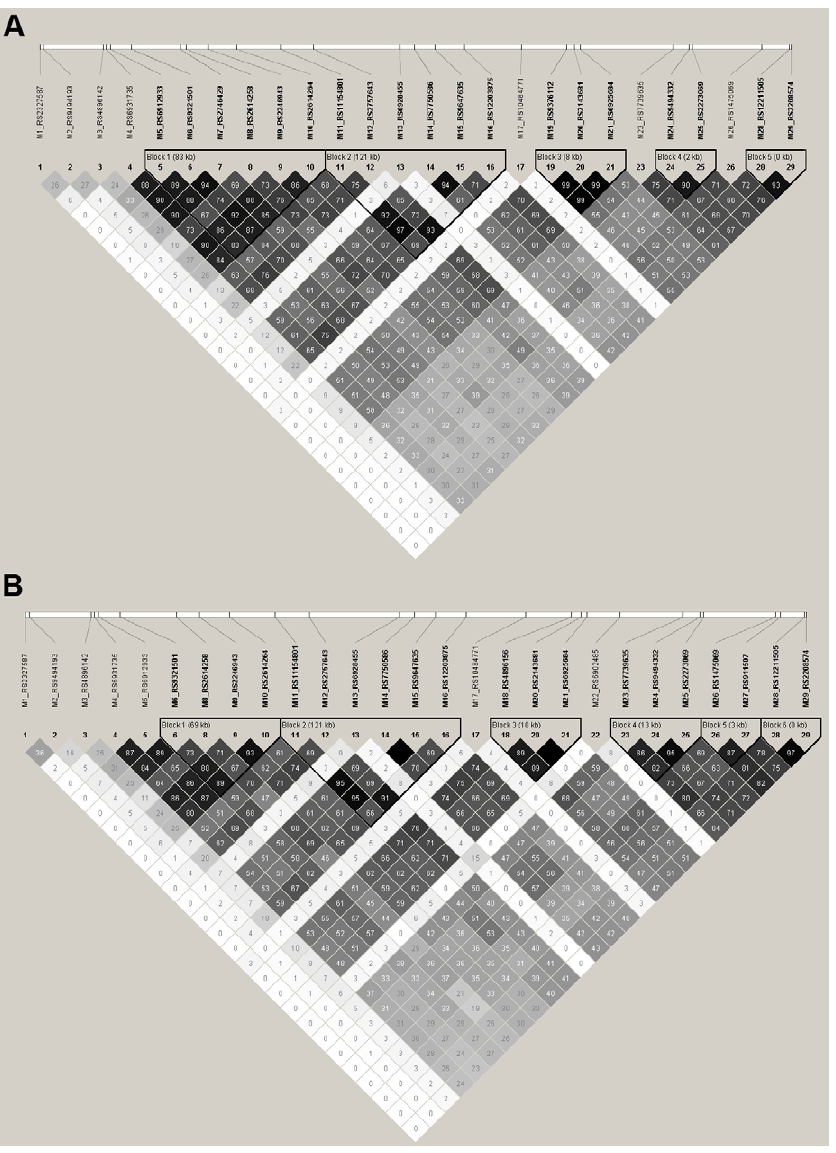
Figure 1. Linkage disequilibrium (LD) pattern of AHI1 gene. Figures represent pairwise r 2 values observed in control subjects from German (a) and Spanish (b) origin. Values are represented in a grayscale ranging from white (no LD) to black (high LD).